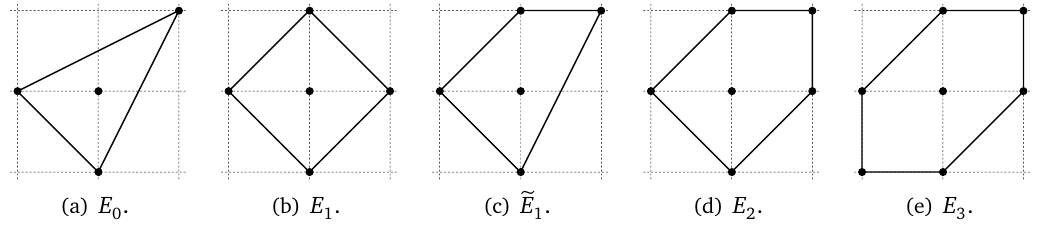
Figure 6: Toric diagrams for the toric CY